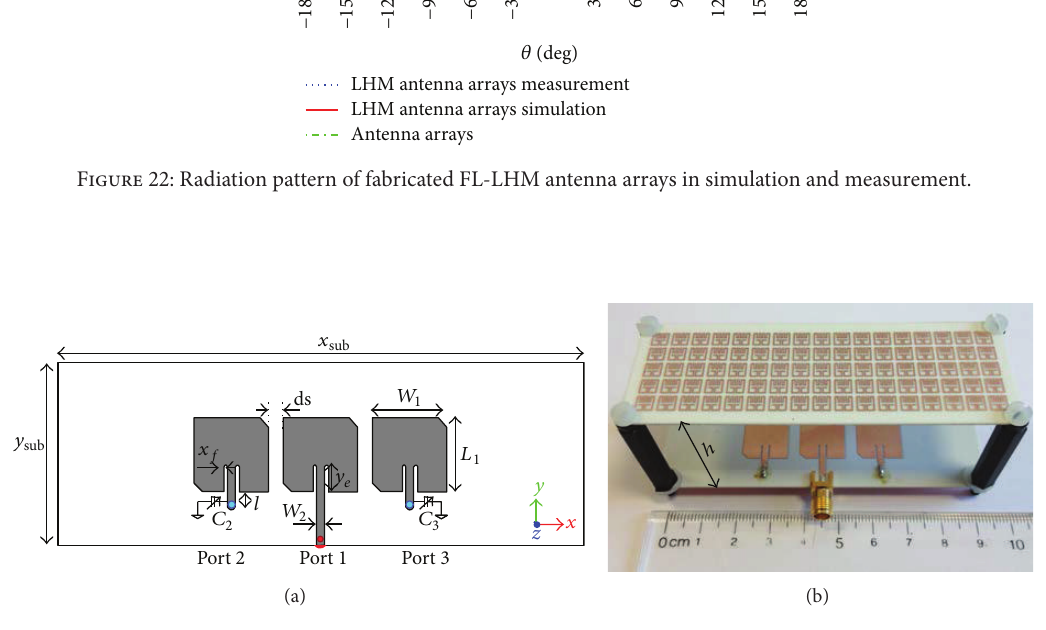
Figure 23: Structure of FL-LHM beam steering antenna: (a) beam steering reference antenna; (b) FL-LHM beam steering antenna with ℎ = 30 mm.